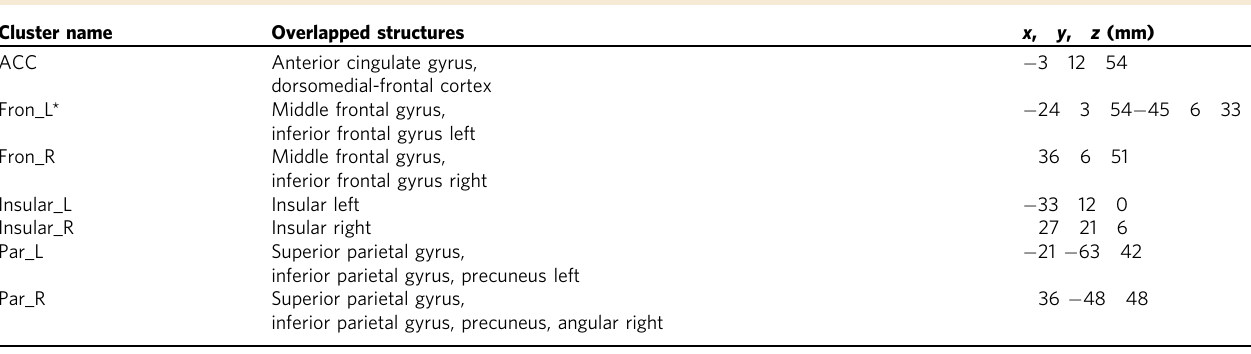
Table 1 The names, coordinates and the overlapped structures of activated GM clusters